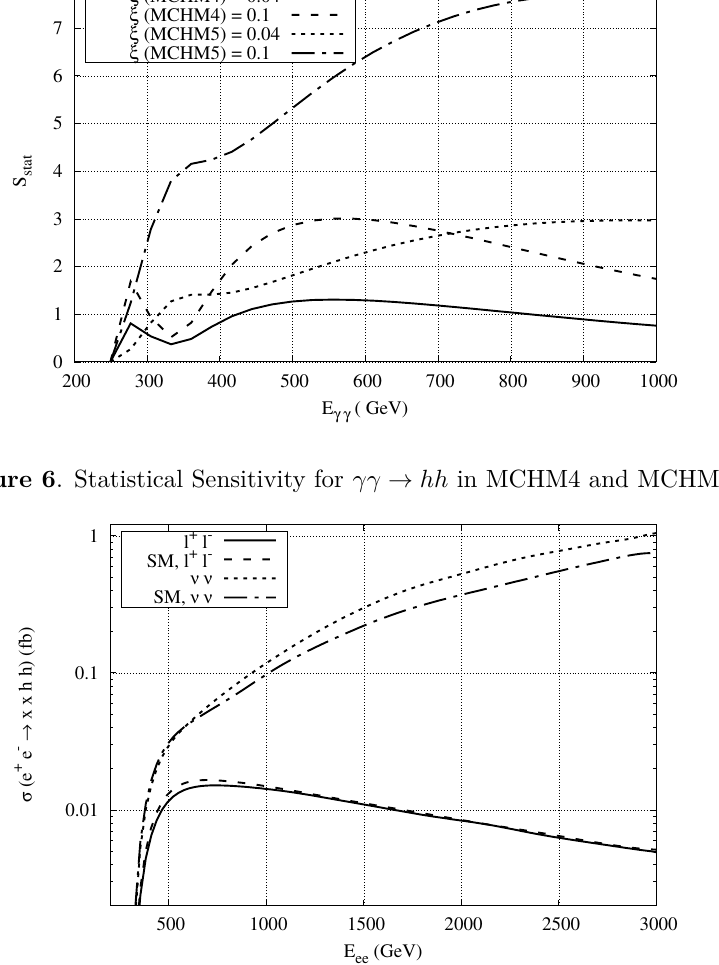
Figure 7 . Cross-section for e + e − → ( ‘ + ‘ − ) / ( ν ¯ ν ) hh in the SM and in the benchmark MCHM5 ( ξ = 0 . 1